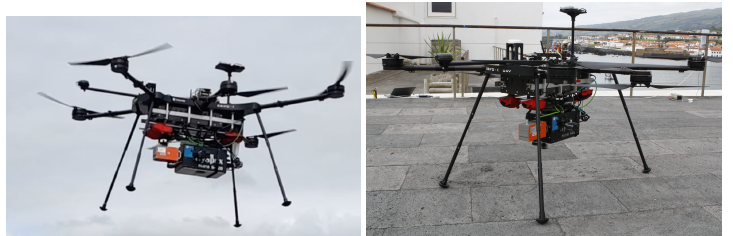
Figure 6. Hyperspectral imaging system mounted in the unmanned aircraft